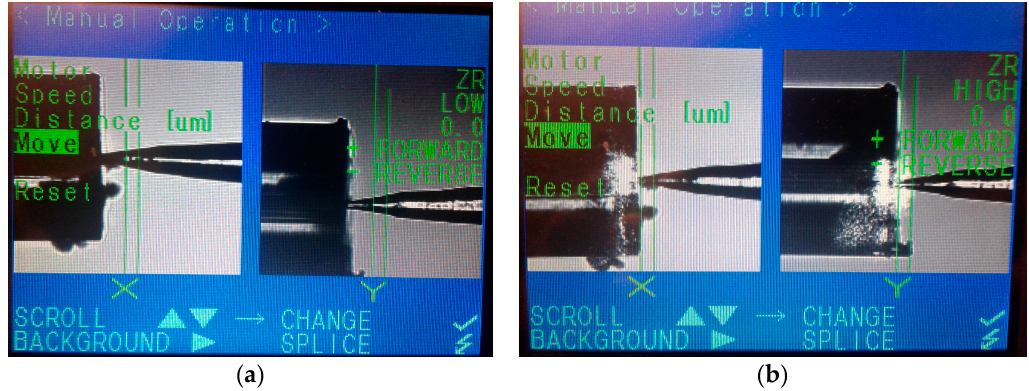
Figure 4. Photo of the tapered tip inside of the MPOF ( a ) with no light source and ( b ) with an He–Ne laser source.